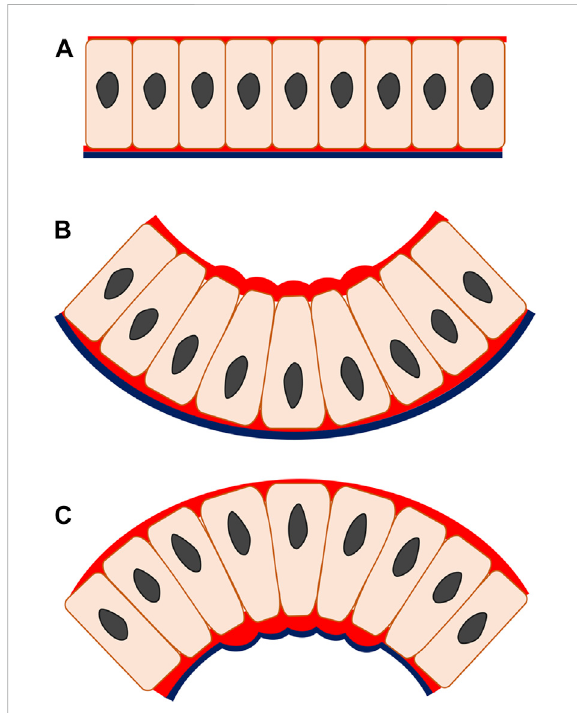
FIGURE 2 Apical and basal constriction seen in monolayer epithelium. In apical constriction (B) , the apical width of the cell is reduced, driven by the actomyosin enrichment on the apical side, enabling cell shape change from columnar to wedged. The epithelial construct changes from a fl at layer (A) to fold inwards (B) , producing invagination. In basal constriction (C) , the reverse applies. The basal width of the cell is reduced due to actomyosin accumulation on the basal side, generating wedged-shape cells and outward bending epithelium termed as evagination. Red, actomyosin; black line, basal